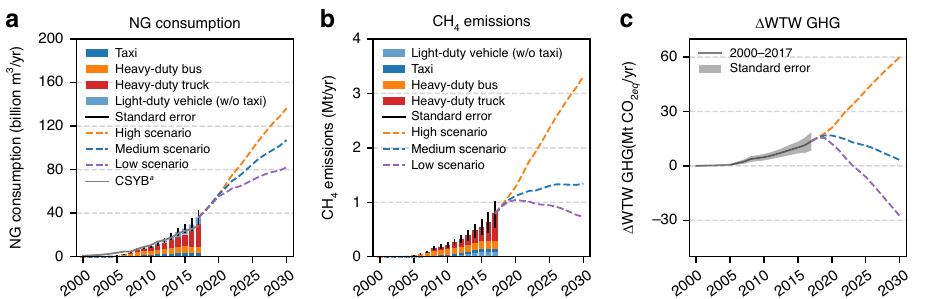
Fig. 4 NG consumption, total CH4 emissions from NGVs, and changes of WTW GHG emissions of switching to NGVs in China from 2000 to 2030. Estimated (bars or solid lines) and projected (dashed lines) NG consumption ( a ), total CH 4 emissions from NGVs ( b ), and changes of WTW GHG emissions of switching to NGVs ( c ) in China from 2000 to 2030. Gray line in a shows the reported NG consumption for the Transport, Storage, and Post sector reported in the China Statistical Yearbook (CSYB). When comparing the estimated NG consumption and NG consumption from CSYB, light-duty vehicles (without taxis) should be excluded (light blue bar in a ). The error bars in a and b and the gray area in c indicate high and low estimates derived using error propagation of uncertainties of multiple input parameters. Uncertainty estimates (standard deviation, S.D.) of individual parameters are listed in Supplementary Table 1, 6, 7, 8, and 11. Source data are provided as a Source Data fi le.